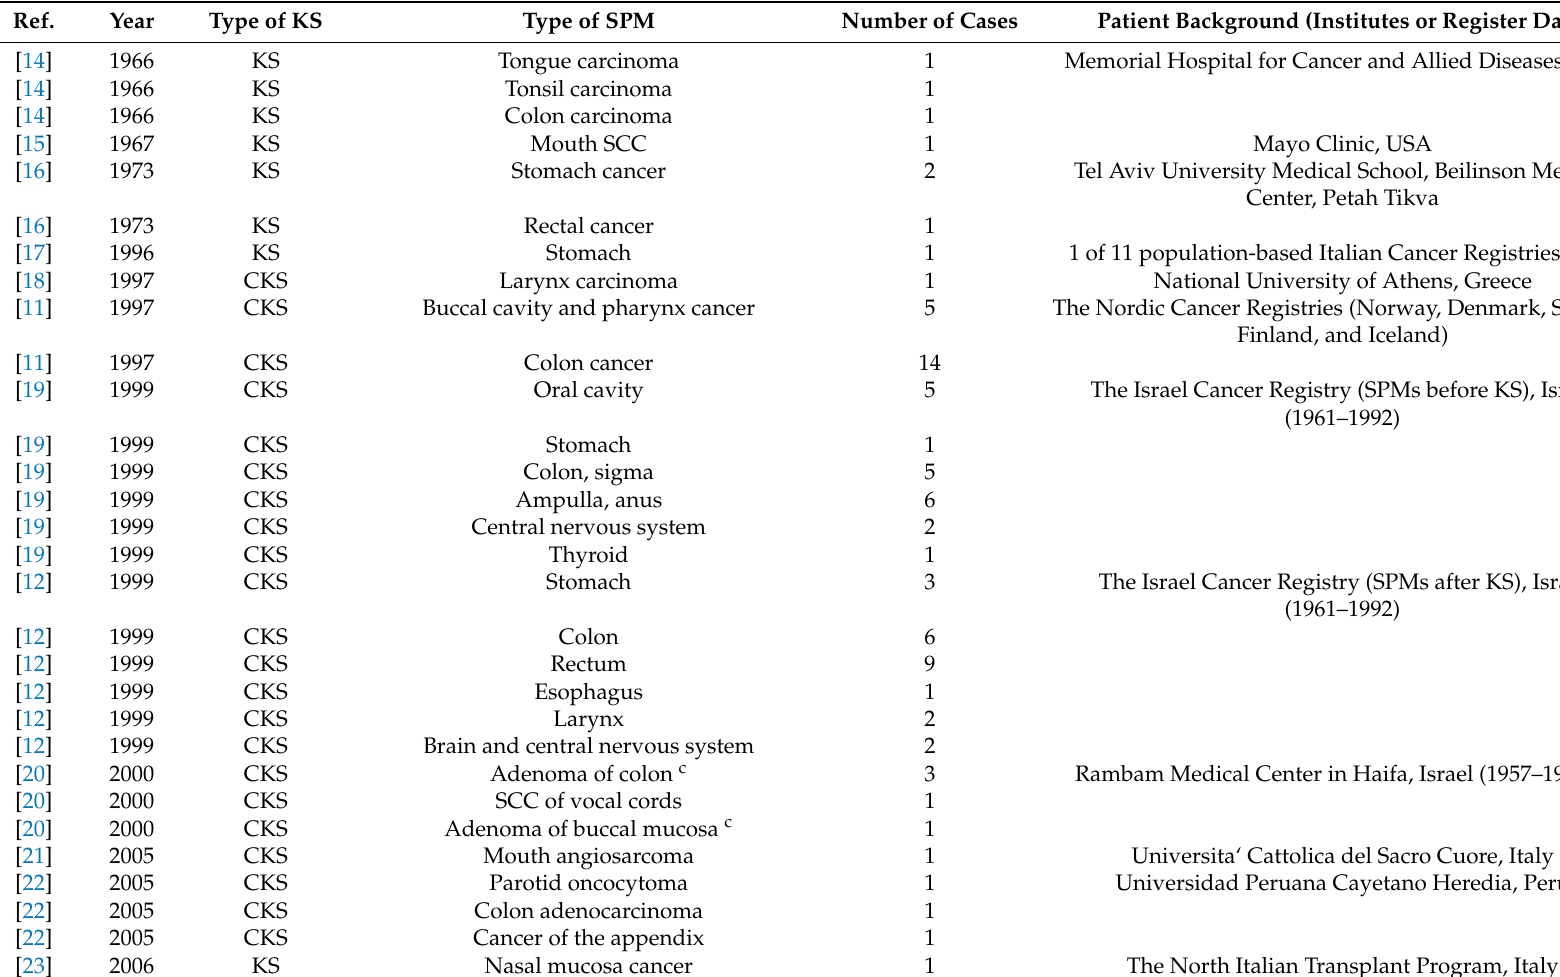
Table 1. Cases of combined Kaposi’s sarcoma (KS) and second primary malignancies (SPMs) of the head and neck, esophagus, stomach, duodenum, or colorectum (including anal).